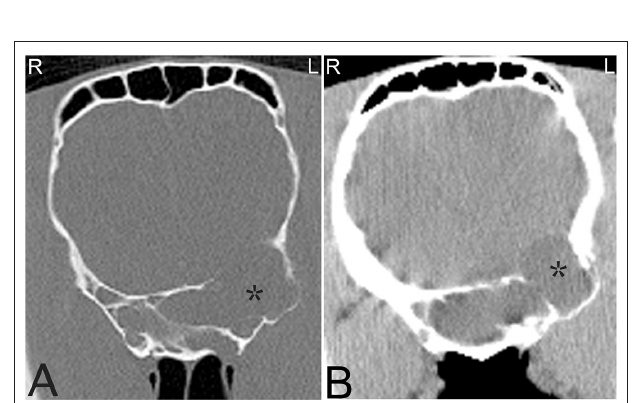
FIGURE 12 | Large sinus cyst involving the sphenopalatine sinus. Computed tomography images of the head of a 5-year-old Thoroughbred mare with an acute onset of blindness of 3 weeks duration. Transverse bone window (A) and soft tissue window (B) CT images of the head at the level of the caudal aspect of the sphenopalatine sinus, illustrate a poorly defined, lobulated, destructive mass in the left sphenopalatine sinus with extension toward the neurocranium (stars). Contrast medium enhancement is not evident centrally but mild enhancement is present peripherally (B) . Histopathology revealed a sinus cyst with extension into the neurocranium thereby compressing the optic nerves at the chiasma. No signs of a neoplasia were noted on histopathology. L, left; R, right.